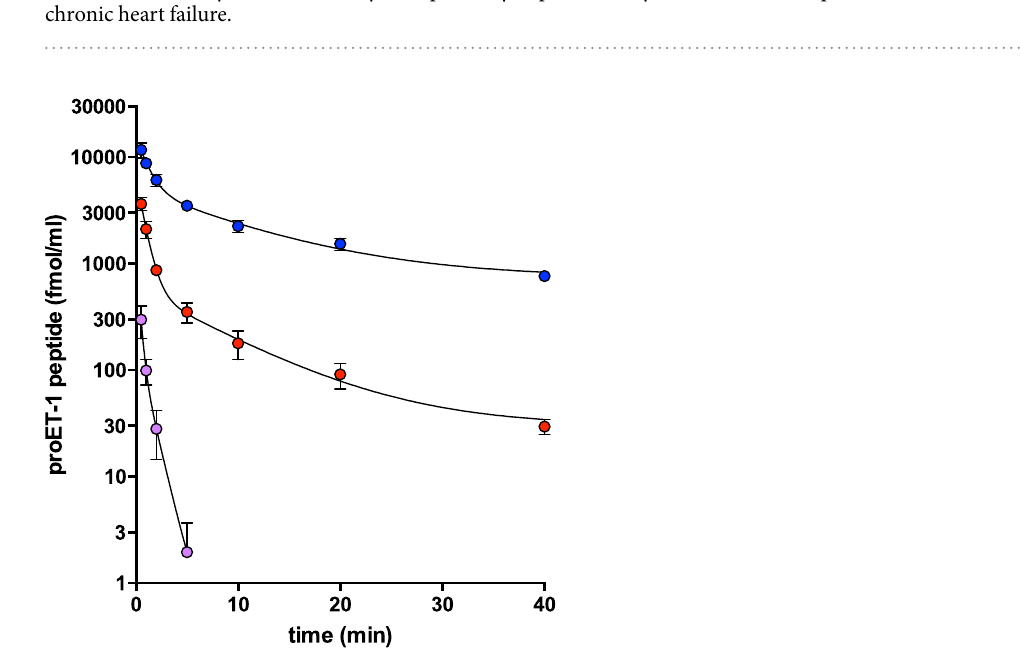
Figure 5. Comparison of clearance rates of NT-proET-1, ELDP and CT-proET-1 in anaesthetised rats. A bolus dose containing 1 nmol/kg of each proET-1 peptide as a combined solution prepared in 0.9% saline/0.1% BSA was administered i.v . and heparinised arterial blood samples (0.5 ml) were collected at 0.5, 1, 2, 5, 10, 20 and 40 min after administration of proET-1 peptides. NT-proET-1 (mauve circles), ELDP (red circles) and CT- proET-1 (blue circles) were measured by magnetic bead-based multiplex assays using Luminex methodology (values are mean ± SD, except where SD is less than the symbol size). Clearance rates for the three peptides were significantly different from each other (2-way ANOVA, P = <